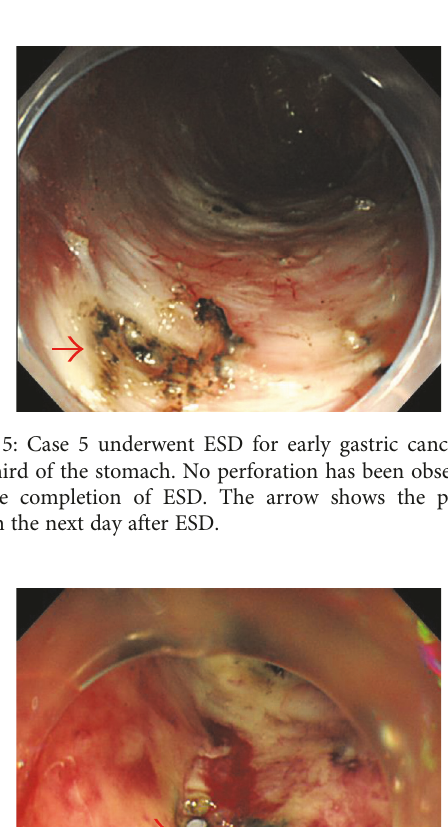
Figure 4: Computed tomography ( CT) showed microfree air (arrow) in the omental bursa.